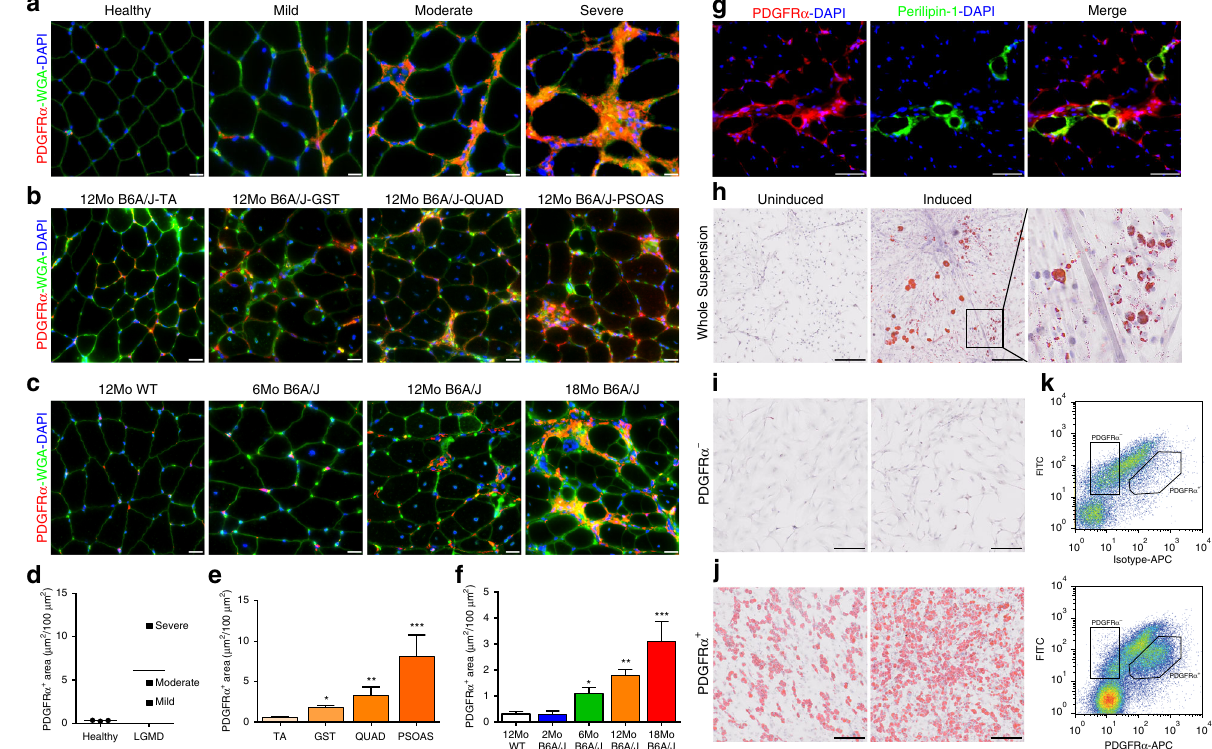
Fig. 2 FAP accumulation and differentiation dictates the extent of adipogenic replacement of dysferlin-de fi cient muscle. PDGFR α staining of FAPs in a mild, moderate, and severe LGMD2B patient and non-dystrophic control muscle cross-sections; b muscles with increasing pathology from 12Mo B6A/J and c gastrocnemius muscle cross-sections from 6, 12, and 18Mo B6A/J and 12Mo WT control. Scale bar = 20 µ m. Quanti fi cation (mean ± SD) of muscle area labeled with PDGFR α in d human and mouse muscle with e increasing pathology and f increasing age. n = 4 mice/group. Statistical comparisons performed via ANOVA with Holm – Sidak multiple comparisons test for all means with 12Mo TA or 12Mo WT respectively, * p < 0.05, ** p < 0.01, *** p < 0.001. g Gastrocnemius muscle cross-section of 12Mo B6A/J co-labeled for PDGFR α and Perilipin-1. Scale bar = 50 µ m. h Oil Red O staining of primary cell suspension isolated from hindlimb muscle of 6Mo B6A/J prior to (uninduced) or following (induced) induction for adipogenic differentiation. Scale bar = 200 µ m. Inset shows a zoomed image of the box drawn in h . Oil Red O staining of sorted cells i lacking or j expressing PDGFR α at their cell surface. Scale bar = 200 µ m. k FACS scatter plots showing cell surface labeling of PDGFR α in primary cell suspension prepared from mouse hindlimb muscle. The regions drawn mark the cells that express or lack cell surface PDGFR α